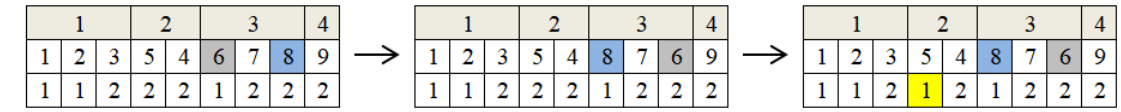
Figure 3. Variation operation diagram.